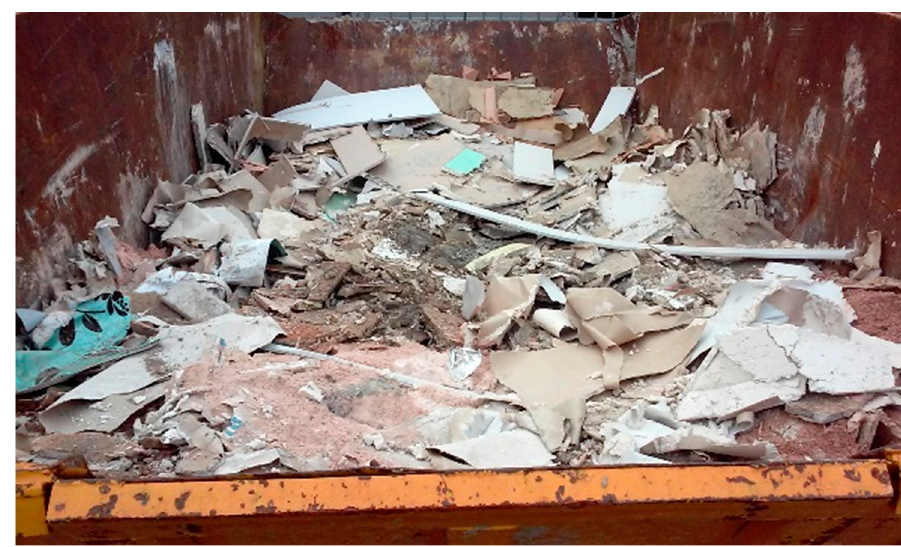
Figure 1. Collected refurbishment plasterboard waste in Nottingham (United Kingdom).